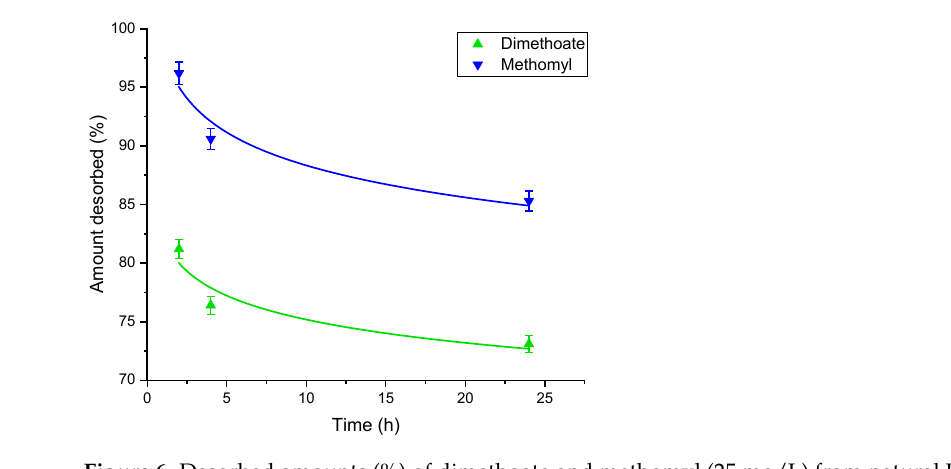
Figure 6. Desorbed amounts (%) of dimethoate and methomyl (25 mg/L) from natural Brari clay.